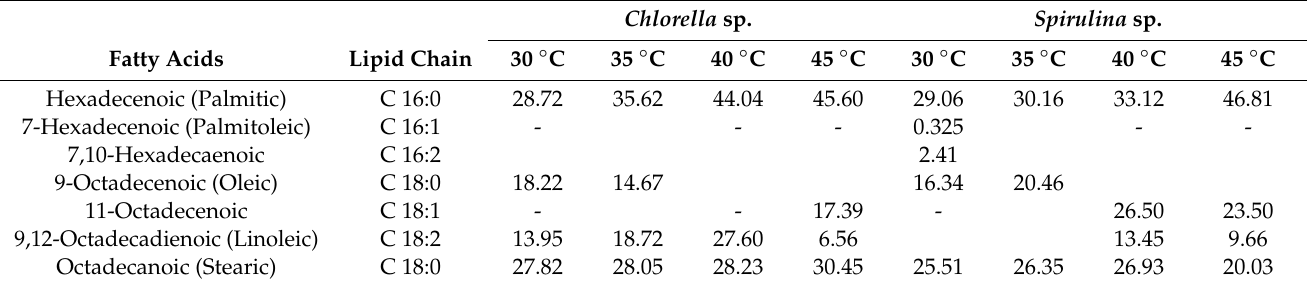
Table 4. Percentage of ester content analyzed by GCMS at di ff erent transesterification operating temperatures. Chlorella